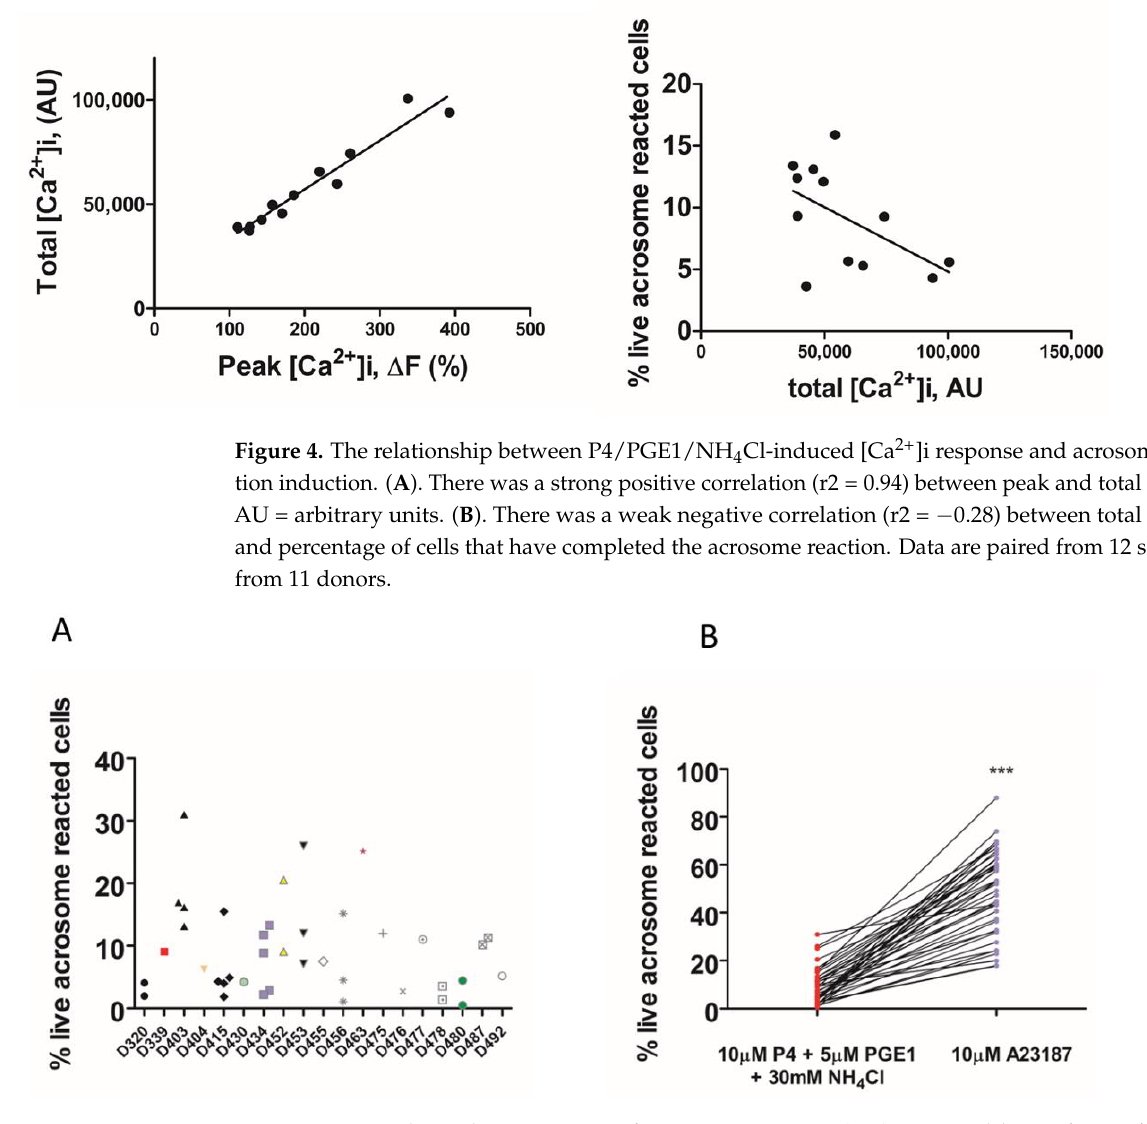
Figure 6. Relationship between the acrosome reaction triggered by P4/PGE1/NH 4 Cl and IVF success rate. ( A ). All patient data. ( B ). Couples with unexplained infertility.